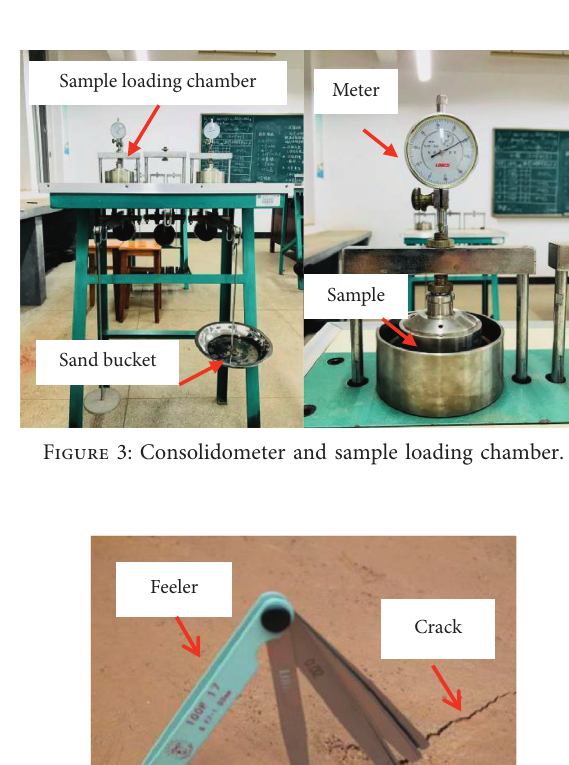
Figure 2: Vetiver cultivation.